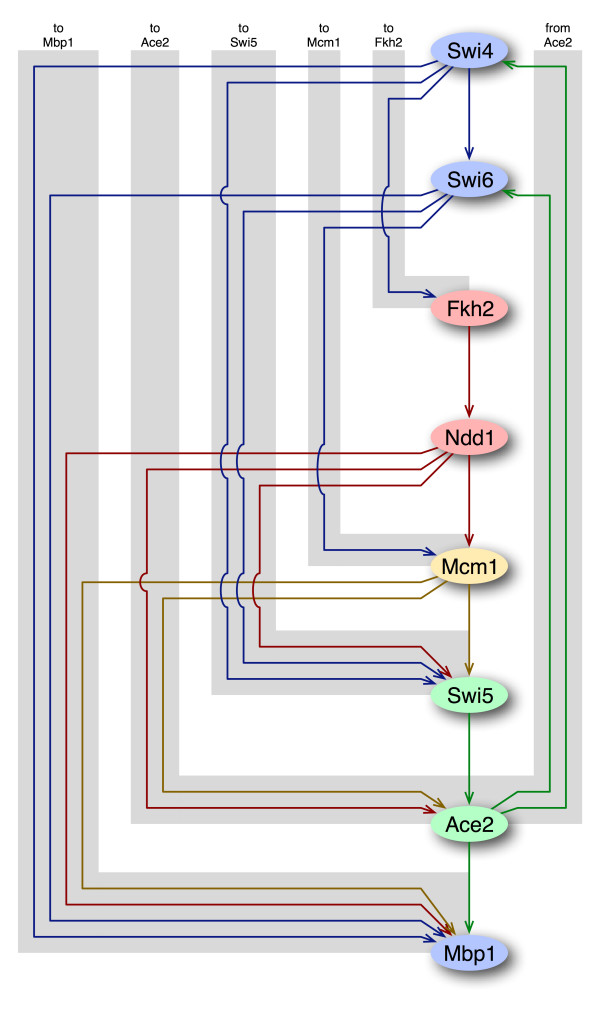
Transcription factor network of canonical cell cycle regulators. We depict the network of canonical transcription factors derived using our approach. We construct a dynamical model of their α-coefficients and show the non-zero edges in this matrix as directed links between factors. A line from factor A to factor B indicates that the activity of A affects the activity of B at the next time point. The displayed order of factors minimizes the number of upward arcs (these arcs being grouped on the right side of the figure).